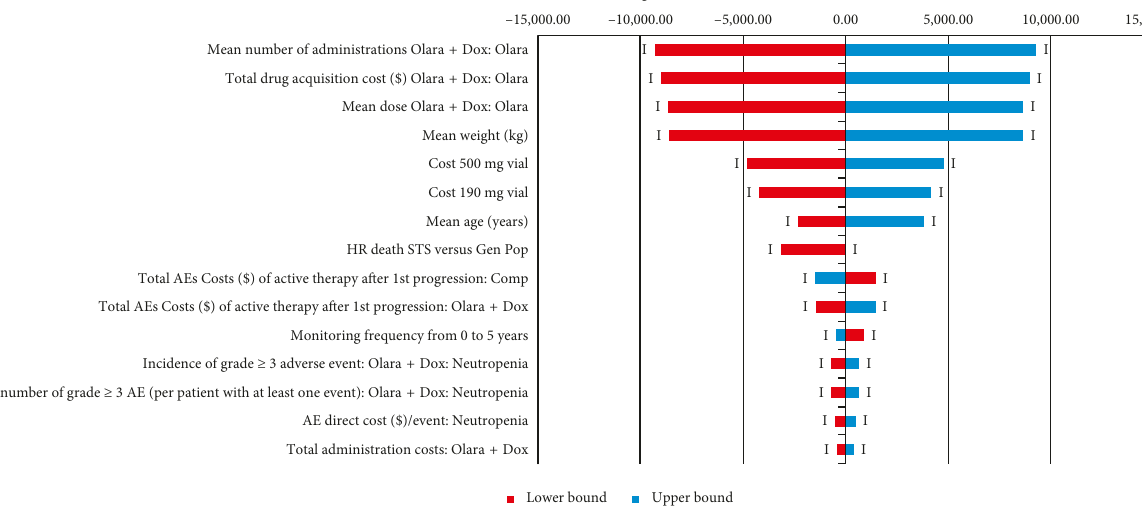
Figure 3: One-way sensitivity analysis tornado diagram for Olara+Dox versus Dox: change in ICER (US $ per LY saved). In the one-way sensitivity analysis, all model parameters were varied individually by +/ 10% of the base-case value with the exception of HR death STS versus Gen Pop, which was changed to 1.00. The plot shows the change in the incremental cost per LY gained for each parameter, ranked in order of largest change in the ICER (the top 15 parameters are shown). In all cases, the ICER remained in quadrant 1 of the cost-effectiveness plane − (Olara+Dox is more expensive and more effective than the comparator) indicated in the graph by a “1” at the end of each bar. AE adverse (cid:31) event; Comp comparator; Dox doxorubicin; Gen Pop general population; HR hazard ratio; ICER incremental cost-effectiveness ratio; (cid:31) (cid:31) (cid:31) (cid:31) (cid:31) LY life year; Olara olaratumab; Olara+Dox olaratumab+doxorubicin; STS soft tissue sarcoma; US United (cid:31) (cid:31) (cid:31) (cid:31) (cid:31)